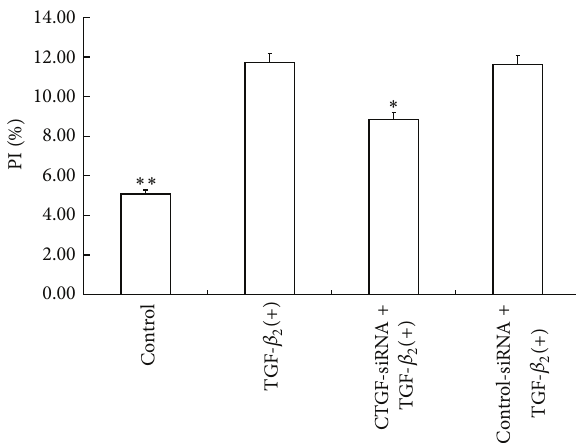
Figure 6: CTGF-siRNA decreases proliferation index of HTFs. HTFs were stimulated with TGF- 𝛽 2 for 48 h after cells were transfected with CTGF-siRNA or control siRNA. PI of HTFs was calculatedaccordingtocellcycleanalyzedbyflowcytometry.CTGF- siRNA decreased the PI of TGF- 𝛽 2 treated cells. Data were from three independent experiments. ∗ 𝑃 < 0.05 , ∗∗ 𝑃 < 0.01 versus TGF- 𝛽 2 (+)